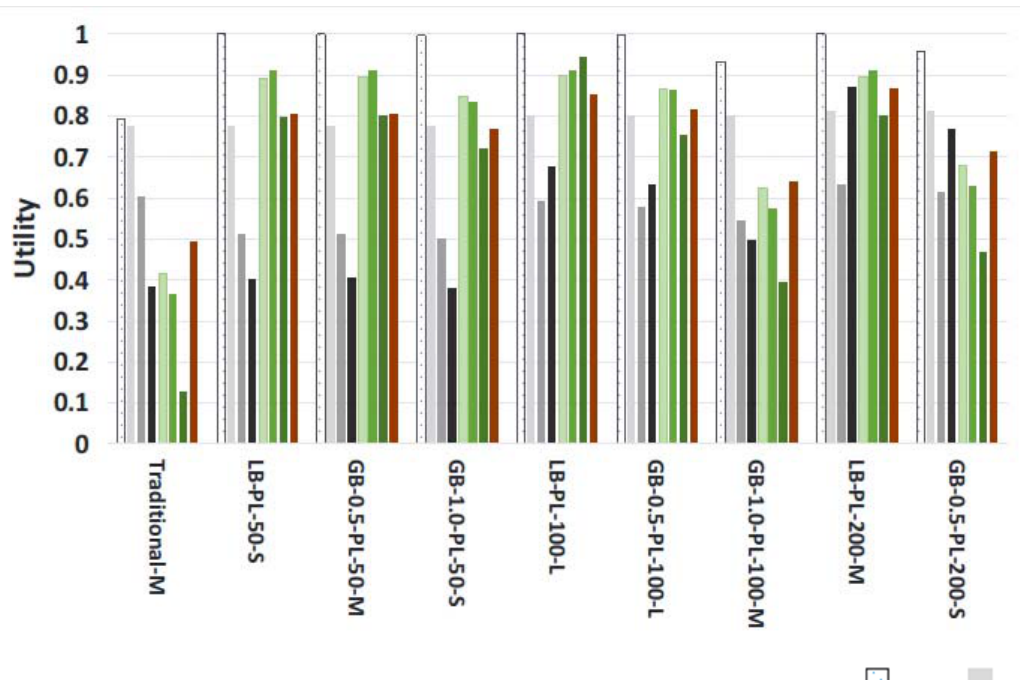
Figure 7. Comparison of the utilities relative to the considered criteria attributes ELP ( ), FIC ( ), VIC ( ), EWPR ( ), IWU ( ), BWUF ( ), IWP ( ), and of the global utilities ( ) for the best project alternatives and the traditional one when applied to a medium infiltration soil.